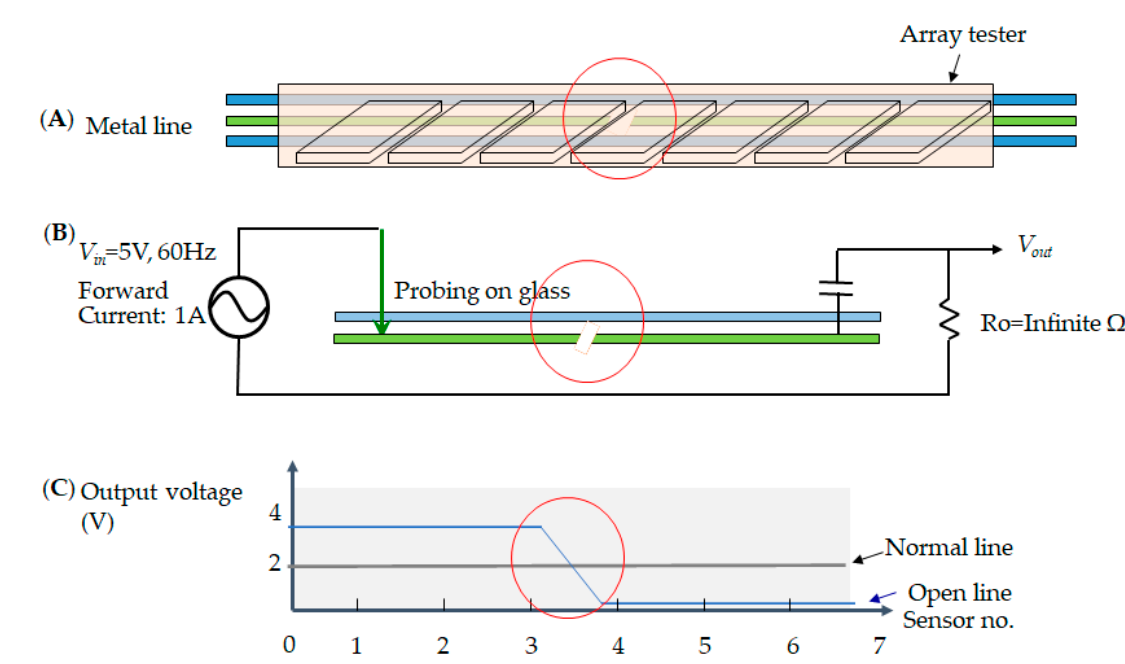
Figure 6. The open defect illustrates ( A ) the array tester on the glass; ( B ) that the sensor cannot receive an output voltage; and ( C ) a voltage tendency two times higher than the output voltage.